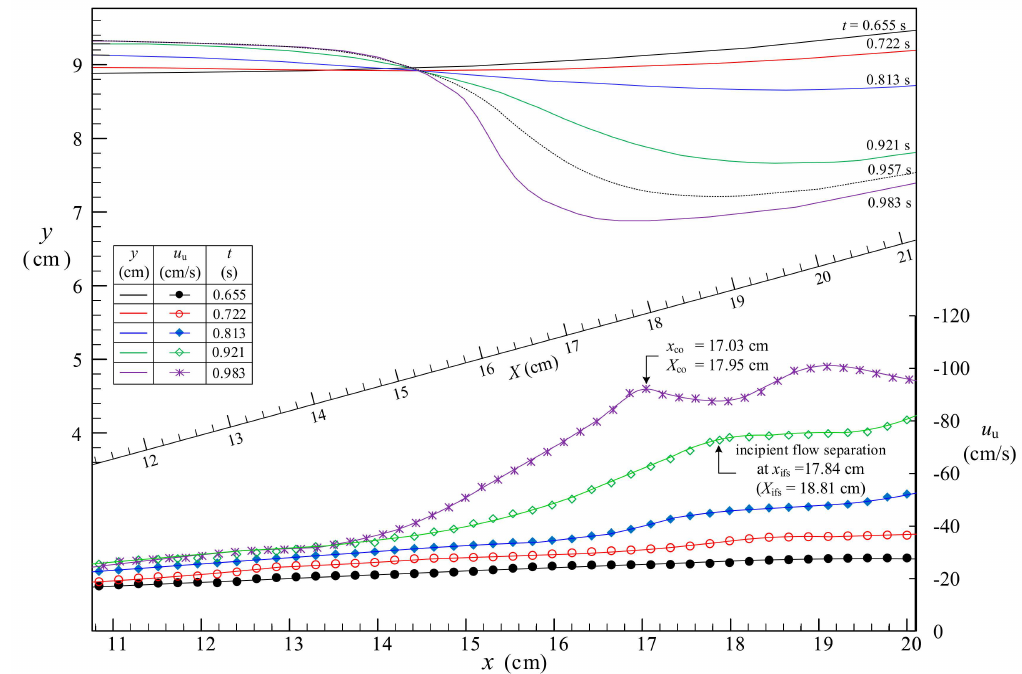
Figure 9. Variation of horizontal uniform velocity with shoreward distance, together with a change of free surface profile for t = 0.655–0.983 s (Case